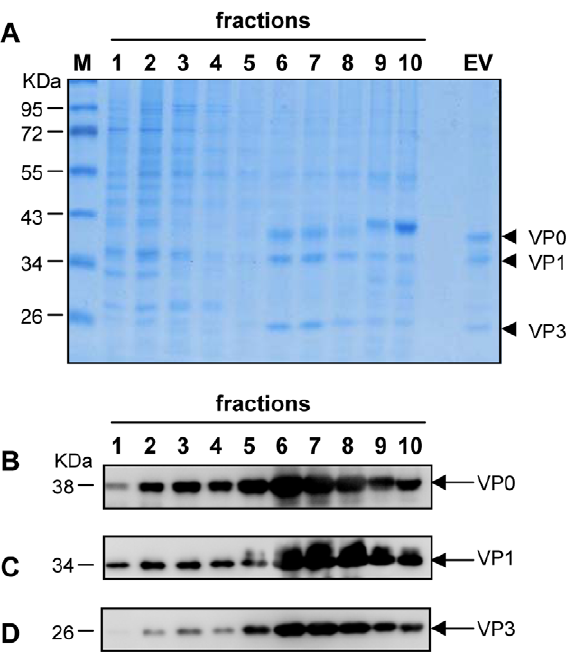
Figure 3. Sucrose gradient analysis. Lysates were layered onto 10– 50% sucrose gradients for ultracentrifugation. Ten fractions were taken from top to bottom. (A) SDS-PAGE analysis. The ten fractions were separated by SDS-PAGE, and subsequently stained with Coomassie Blue dye. M, protein marker. EV, purified whole virion EV71 standard from Hualan Inc. (B) Western blotting with anti-VP0 polyclonal antibody. (C) Western blotting with anti-VP1 polyclonal antibody. (D) Western blotting with anti-VP3 polyclonal antibody.